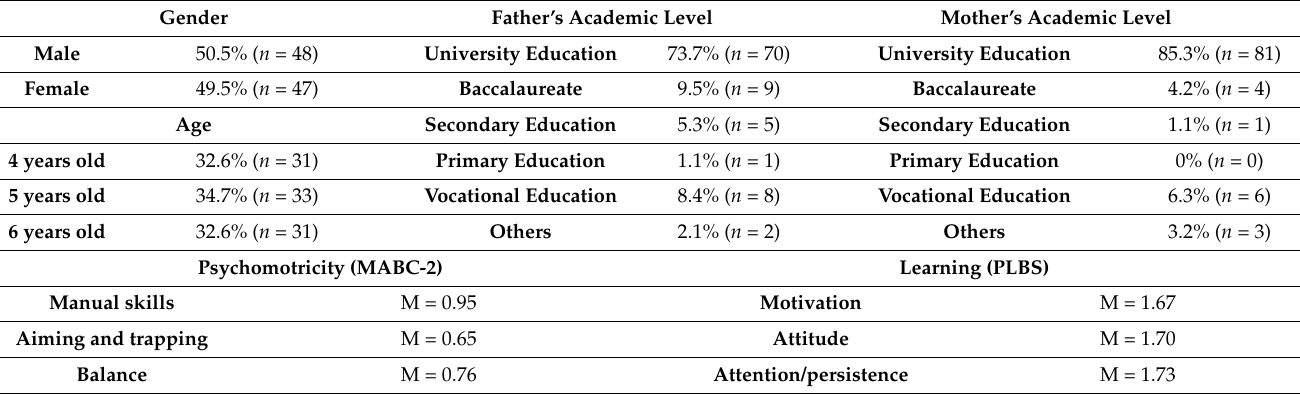
Table 1. Descriptive data of the study.